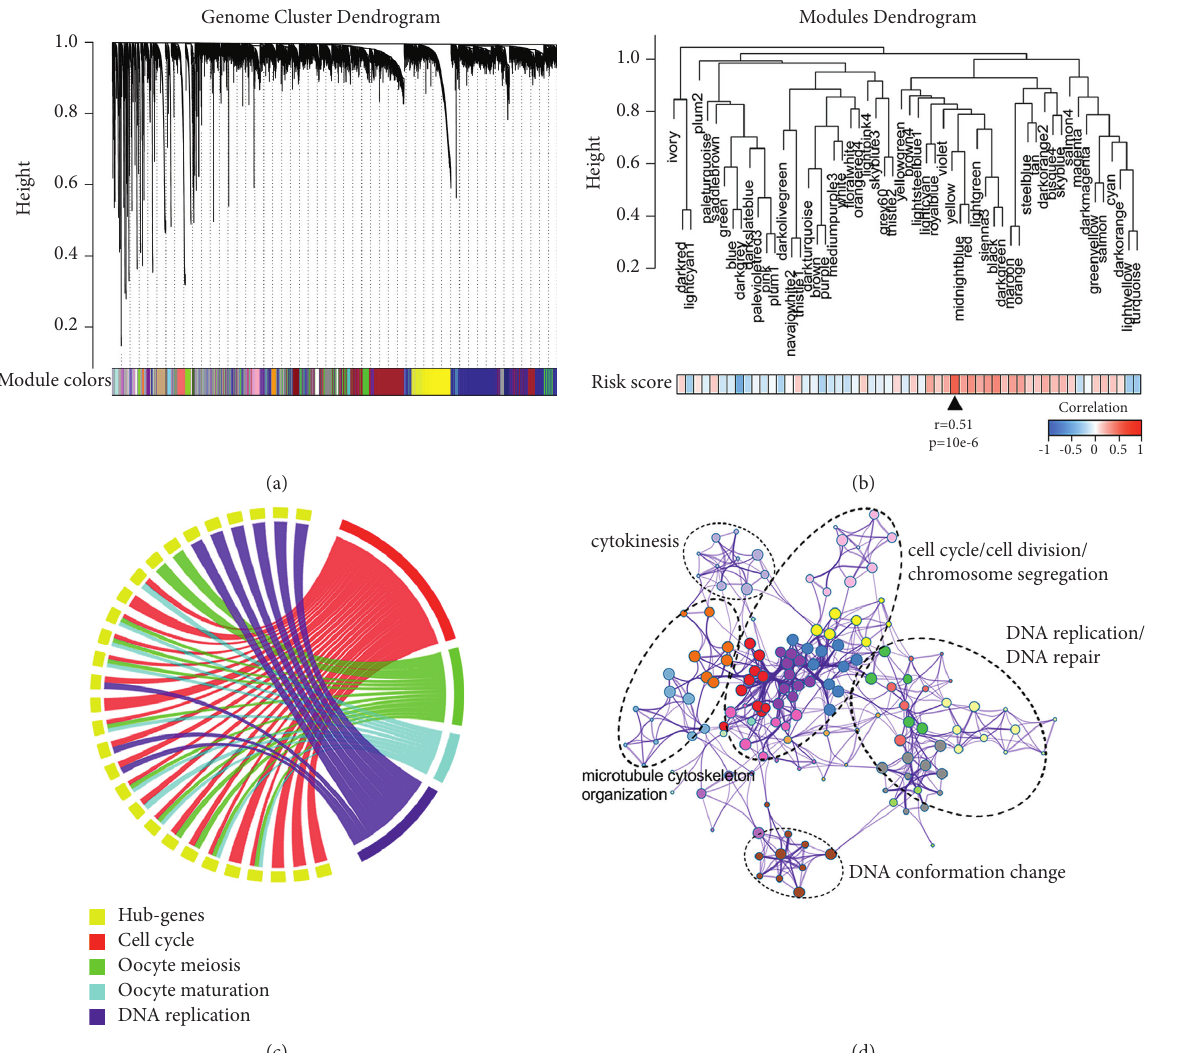
Figure 5: Bioinformatics analyses were performed for annotations of biological processes underlying the gene signature: (a) whole-genome cluster dendrogram; (b) modules dendrogram and heatmap of relationships between risk score and different modules; (c) Circos showed that most hub genes were enriched in the cell-cycle-related processes; and (d) visualized GO enrichment biological